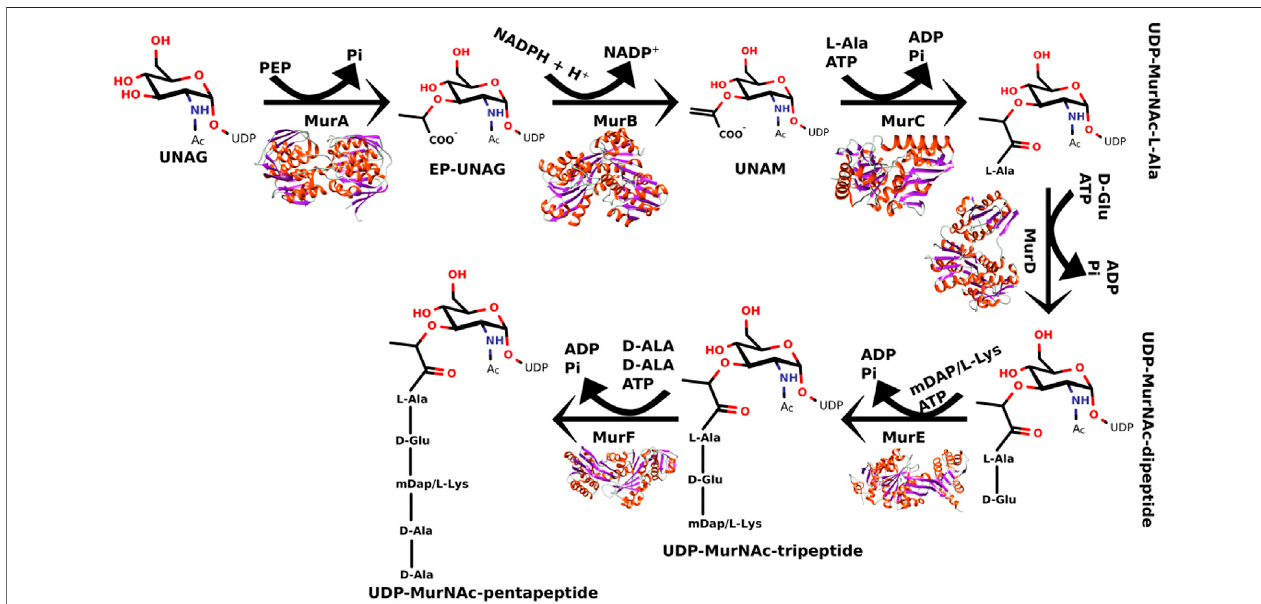
FIGURE 1 | Steps of catalytic reactions performed by the MurA-MurF enzymes in the peptidoglycan biosynthesis.